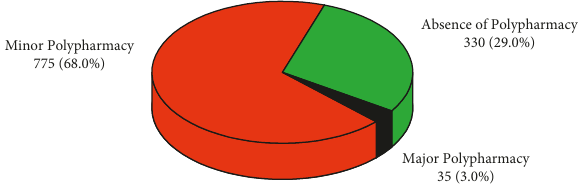
Figure 2: Levels of polypharmacy based on the prescribed med- ications ( N � 1140) at Edna Adan university, between August 28,